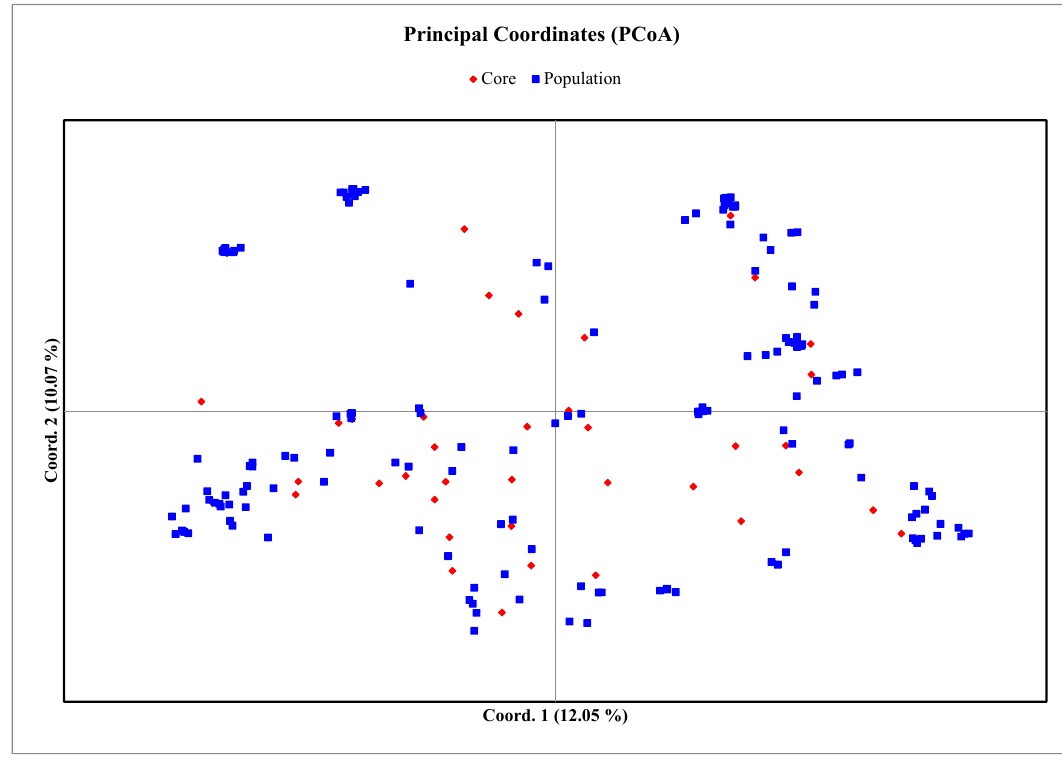
Figure 6. Principal Coordinate Analysis (PCoA) plot showing accessions selected for the core collection of the buffelgrass collection.